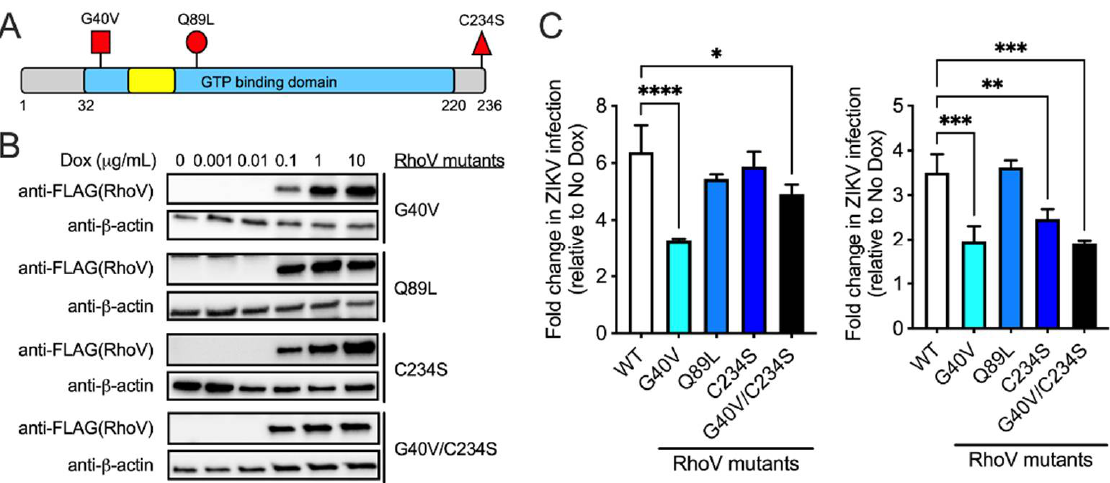
Figure 5. RhoV GTPase domain contributes to its proviral effects during ZIKV infection. ( A ) Schematic of RhoV protein domains and mutations introduced (red flags). The GTP binding/hydrolysis domain (blue), effector or switch I domain (yellow), and N- and C-terminal extension regions (gray) are shown. Adapted from [18]. ( B ) SNB-19 cells were treated with different amounts of Dox (0, 0.001, 0.01, 0.1, 1 and 10 µ g/mL) for 24 h to induce the expression through the ePiggyBac transposon system of N-terminally 3 × FLAG-tagged RhoV WT or mutants that are dominant-activated, GTPase-defective (G40V, Q89L), mislocalized (C234S), or both (G40V/C234S). Mutant RhoV and β -actin (loading control) protein expression was determined by immunoblotting with FLAG and β -actin antibodies. The data are representative of two independent experiments. ( C ) Two independent experiments are shown here (left and right). Inducible RhoV (WT or mutants) SNB-19 cells were treated with or without 0.25 µ g/mL Dox for 24 h prior to 1 h adsorption with ZIKV (MOI = 0.5 PFU/cell) and harvested at 24 h.p.i. to quantify infection levels. Dox was added back to the media during the course of infection. ZIKV infected cells were then fixed and permeabilized to stain with the pan-flavivirus envelope antibody prior to flow cytometry analysis. Infection levels of RhoV WT and mutant cell lines were normalized to that of the respective untreated condition (no Dox) and reported as fold changes. Asterisks indicate statistically significant differences (one-way ANOVA and Dunnett’s multiple comparisons test: *, p < 0.05; **, p < 0.01; ***, p < 0.001; ****, p < 0.0001).